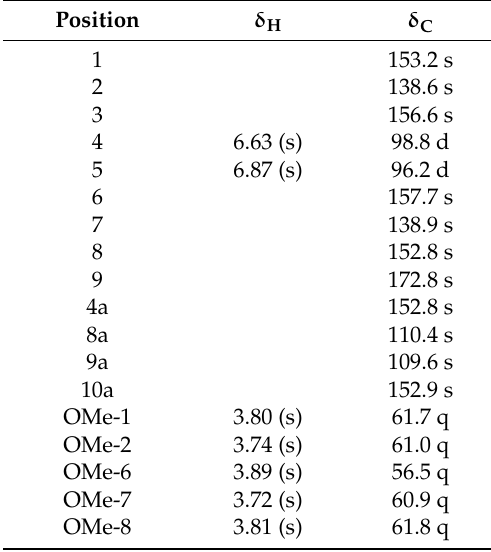
Table 1. The 1 H (600 MHz) and 13 C-NMR (125 MHz) data of A in DMSO- d 6 . Position δ H δ